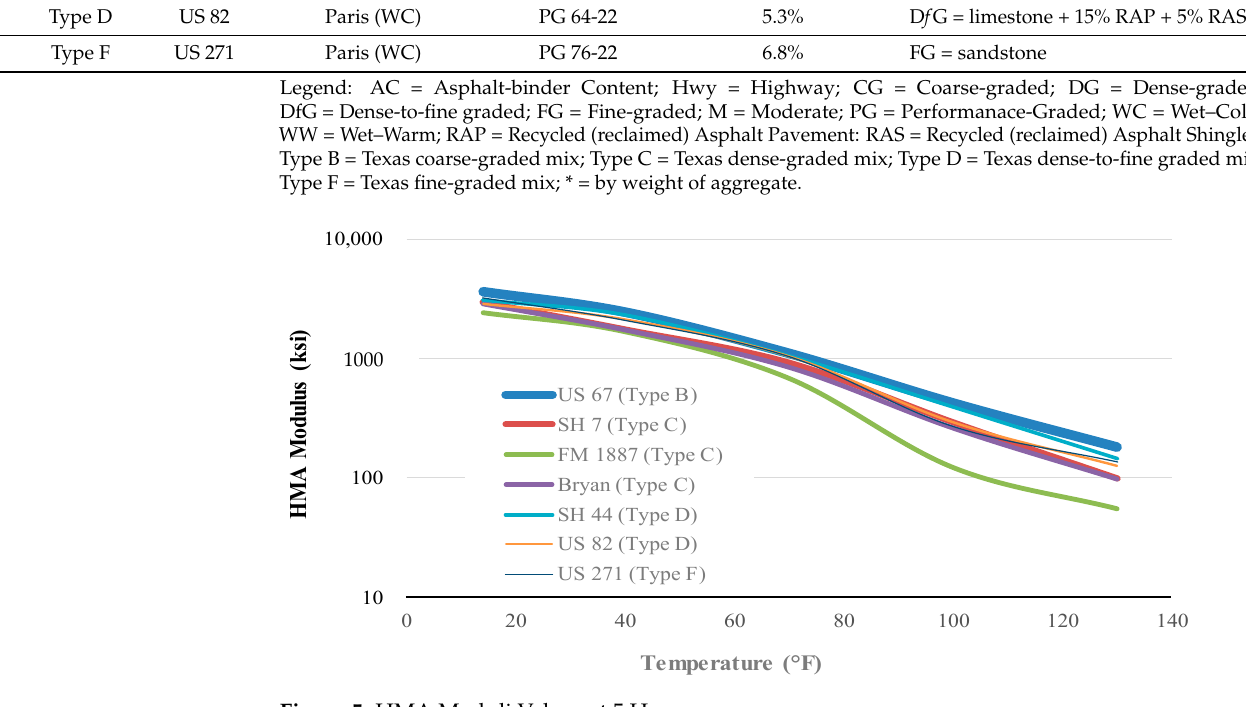
Figure 5. HMA Moduli Values at 5 Hz.